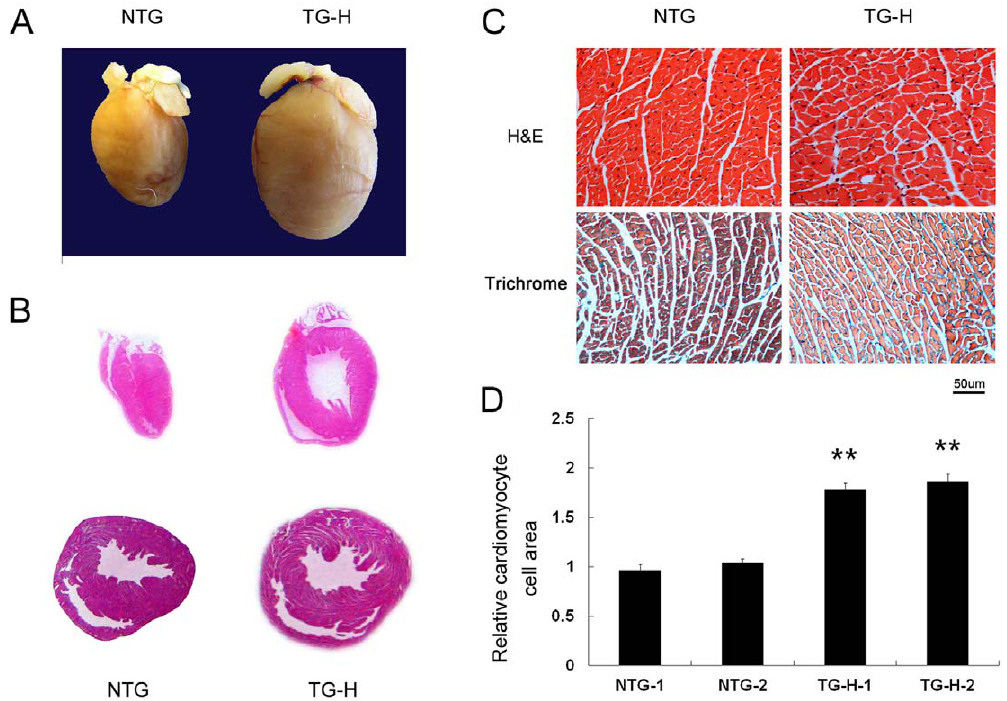
Figure 3. Cardiac histological analysis of TNNI3K transgenic mice at the age of 3 Months. (A) Whole heart, (B) Macroscopic view after hematoxylin–eosin-stained hearts revealed a concentric hypertrophy in TG-H mice. Upper was longitudinally sectioned. Lower was transversely sectioned. (C) Microscopic histological analysis of demonstrated cardiomyocyte hypertrophy without an increase in interstitial fibrosis in TG-H hearts. Upper panel was H&E stained sections. Lower panel was trichrome stained sections. Blue staining represents collagen deposition. Original magnification x200 (D) Cross-sectional areas of cardiomyocyte were quantified from hematoxylin–eosin-stained histological sections. At least 150 myocytes were measured each in two non-transgenic (NTG) hearts and two TG-H transgenic heart. **P , 0.01 compared with wild-type.